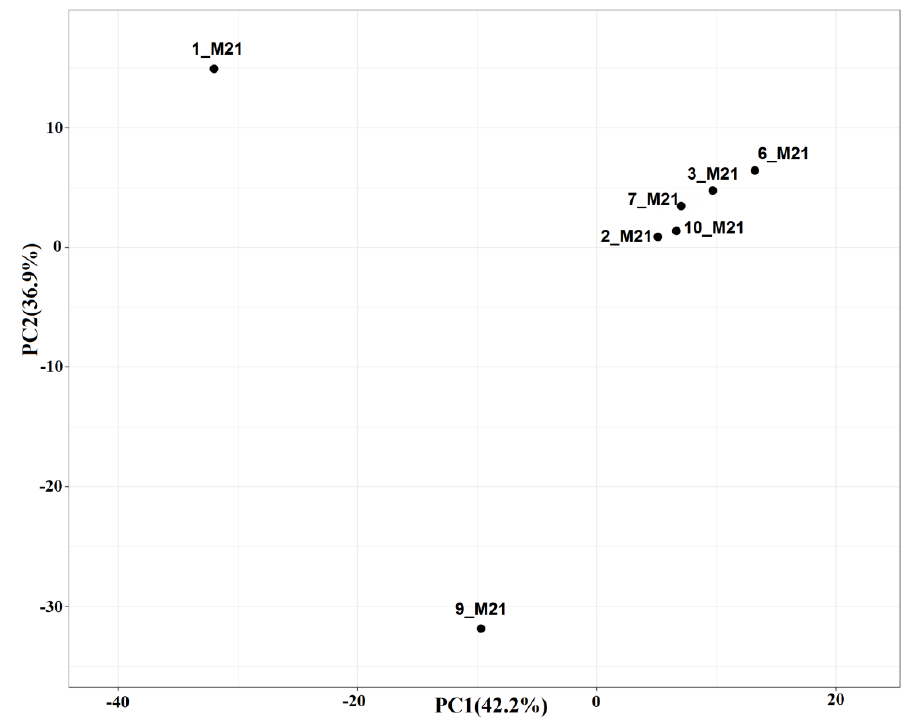
Figure 1. Comparison of the composition of microbial communities from seawater, littoral sandy mud, and coastal soil samples by principal component analysis (PCA) based on the relative abundance of operational taxonomic units (OTUs) derived from clustering the 16S rRNA genes ( ≥ 97% similarity) of prokaryotes. Library designations: prokaryotic communities in samples of seawater (1_M21 and 2_M21), littoral soil (3_M21, 6_M21, and 10_M21), and coastal soil (7_M21 and 9_M21) collected at the Murmansk region.